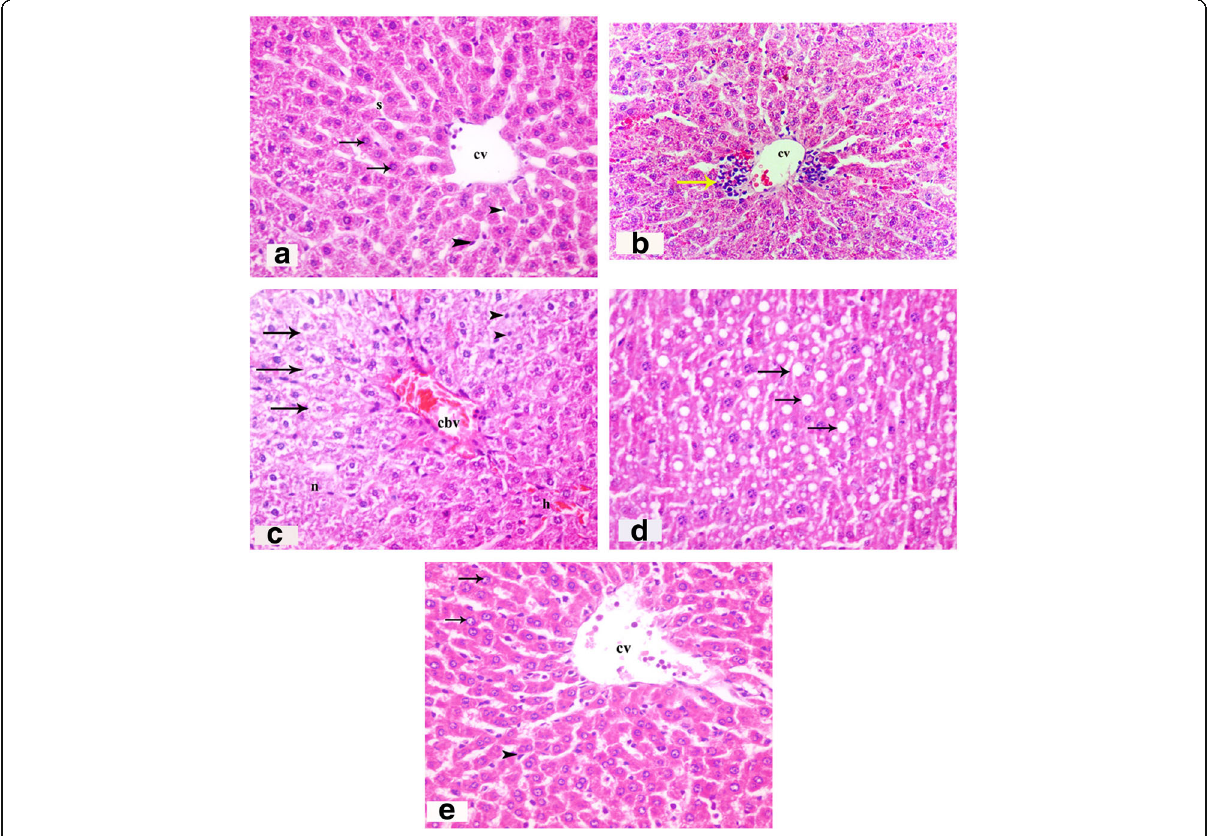
Fig. 1 a Section in control rat showing classic hepatic architecture with normal central vein (cv), hexagonal hepatocyte with central round nucleus (arrow), sinusoids (s) with Kupffer cells (arrow head). b Section in rat treated with CP showing leucocytic infiltration (yellow arrow). c CP-treated rat showing congested blood vessel (cbv), cytoplasmic vaculation (arrows), necrosis (n), pyknosis (arrow head), hemorrhage (h). d CP-treated rat showing fatty degeneration. e Section in rat treated with ABG and CP showing marked improvement of hepatic tissue with normal hepatocytes (arrows)